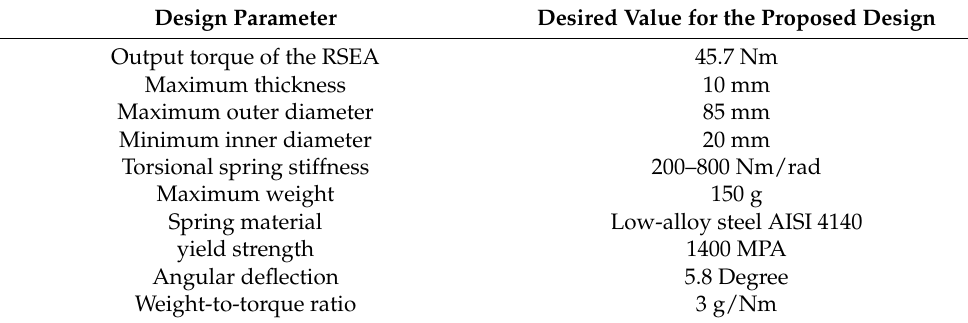
Table 2. Design requirements of the torsional spring. Design